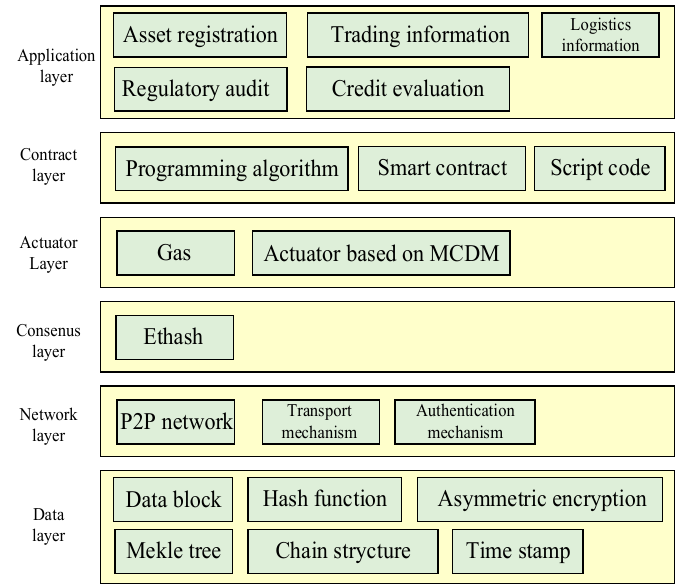
Figure 2. E-commerce system framework based on blockchain.